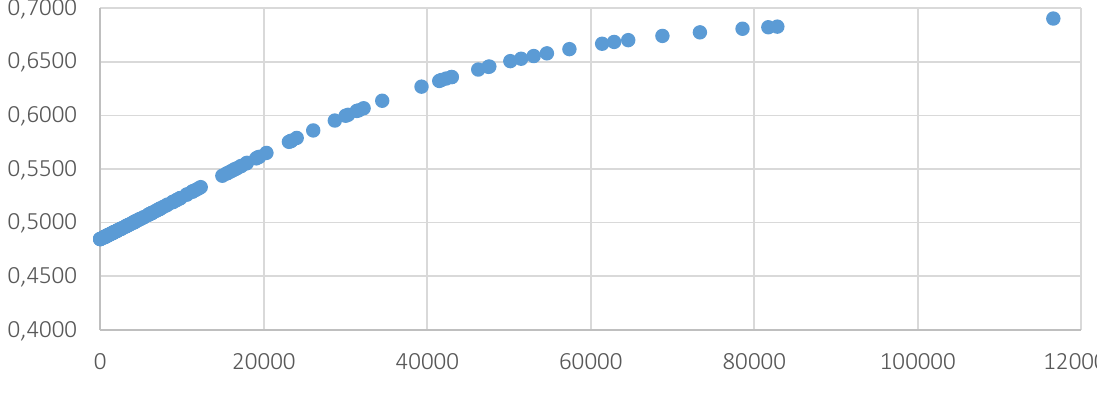
Figure 3. Graph of the second type of the curve for GDP per capita